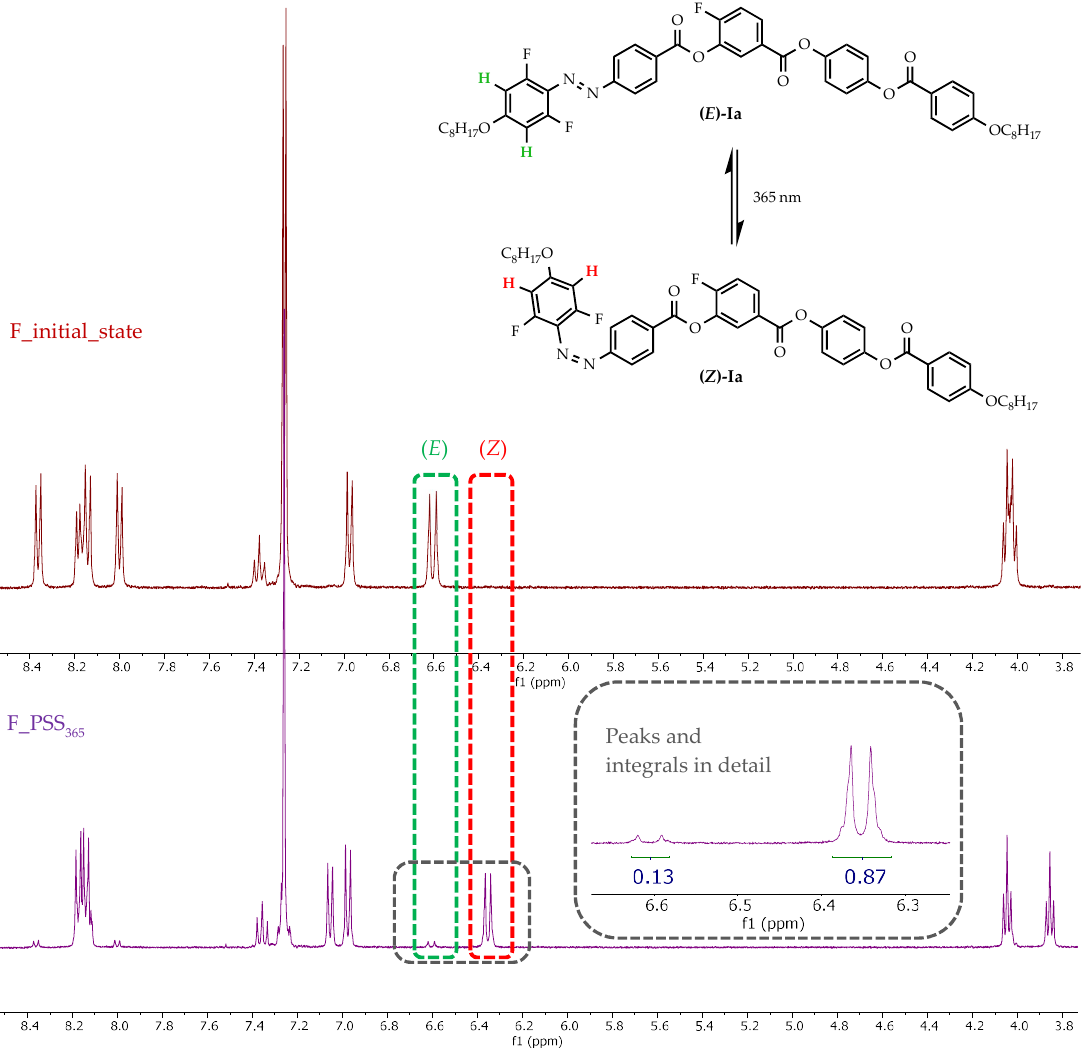
Figure 7. Determination of the ( E )/( Z ) ratio from 1 H NMR spectrum of the material Ia. Integrals of significant signals at 6.60 and 6.36 ppm correspond with percentage of ( E ) and ( Z ) isomers in the solution.